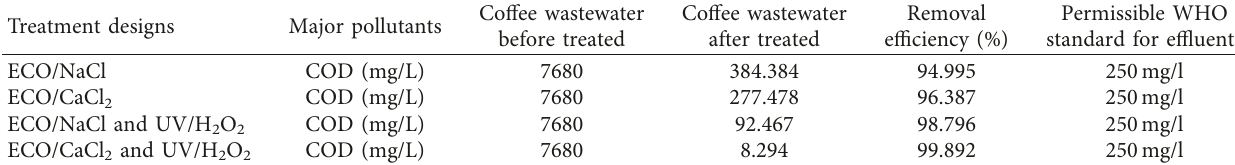
Table 3: Optimum value of pollutant removed by photoelectrochemical